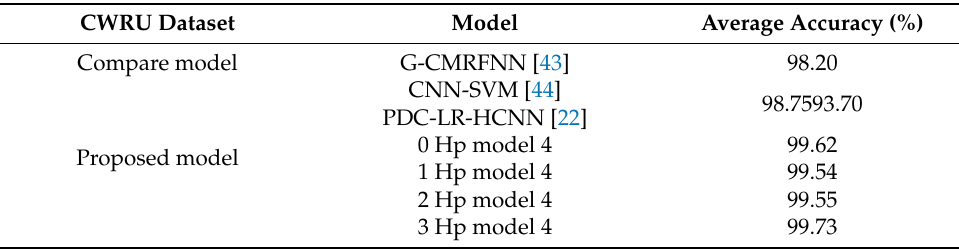
Table 10. Comparison of neural network.